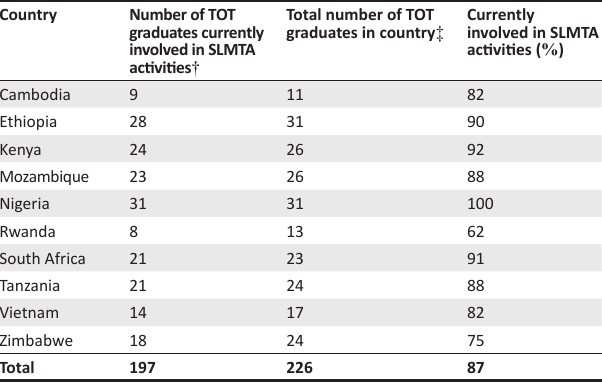
FIGURE 3 : Results from the TOT Graduates TABLE 2 : Results from the country programme leader survey. Country Number of TOT graduates currently